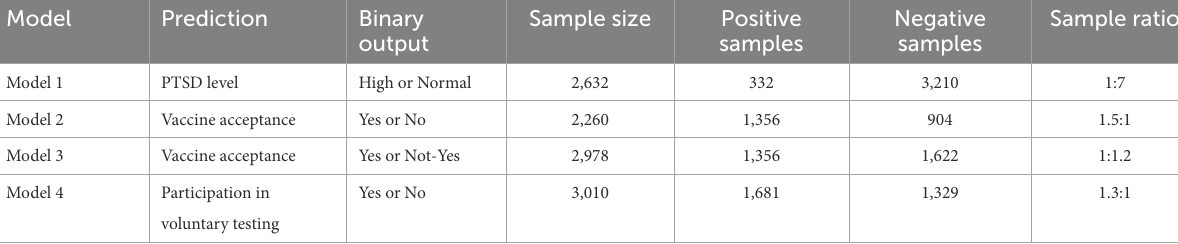
TABLE 1 Prediction outputs and samples used to build the four prediction models.